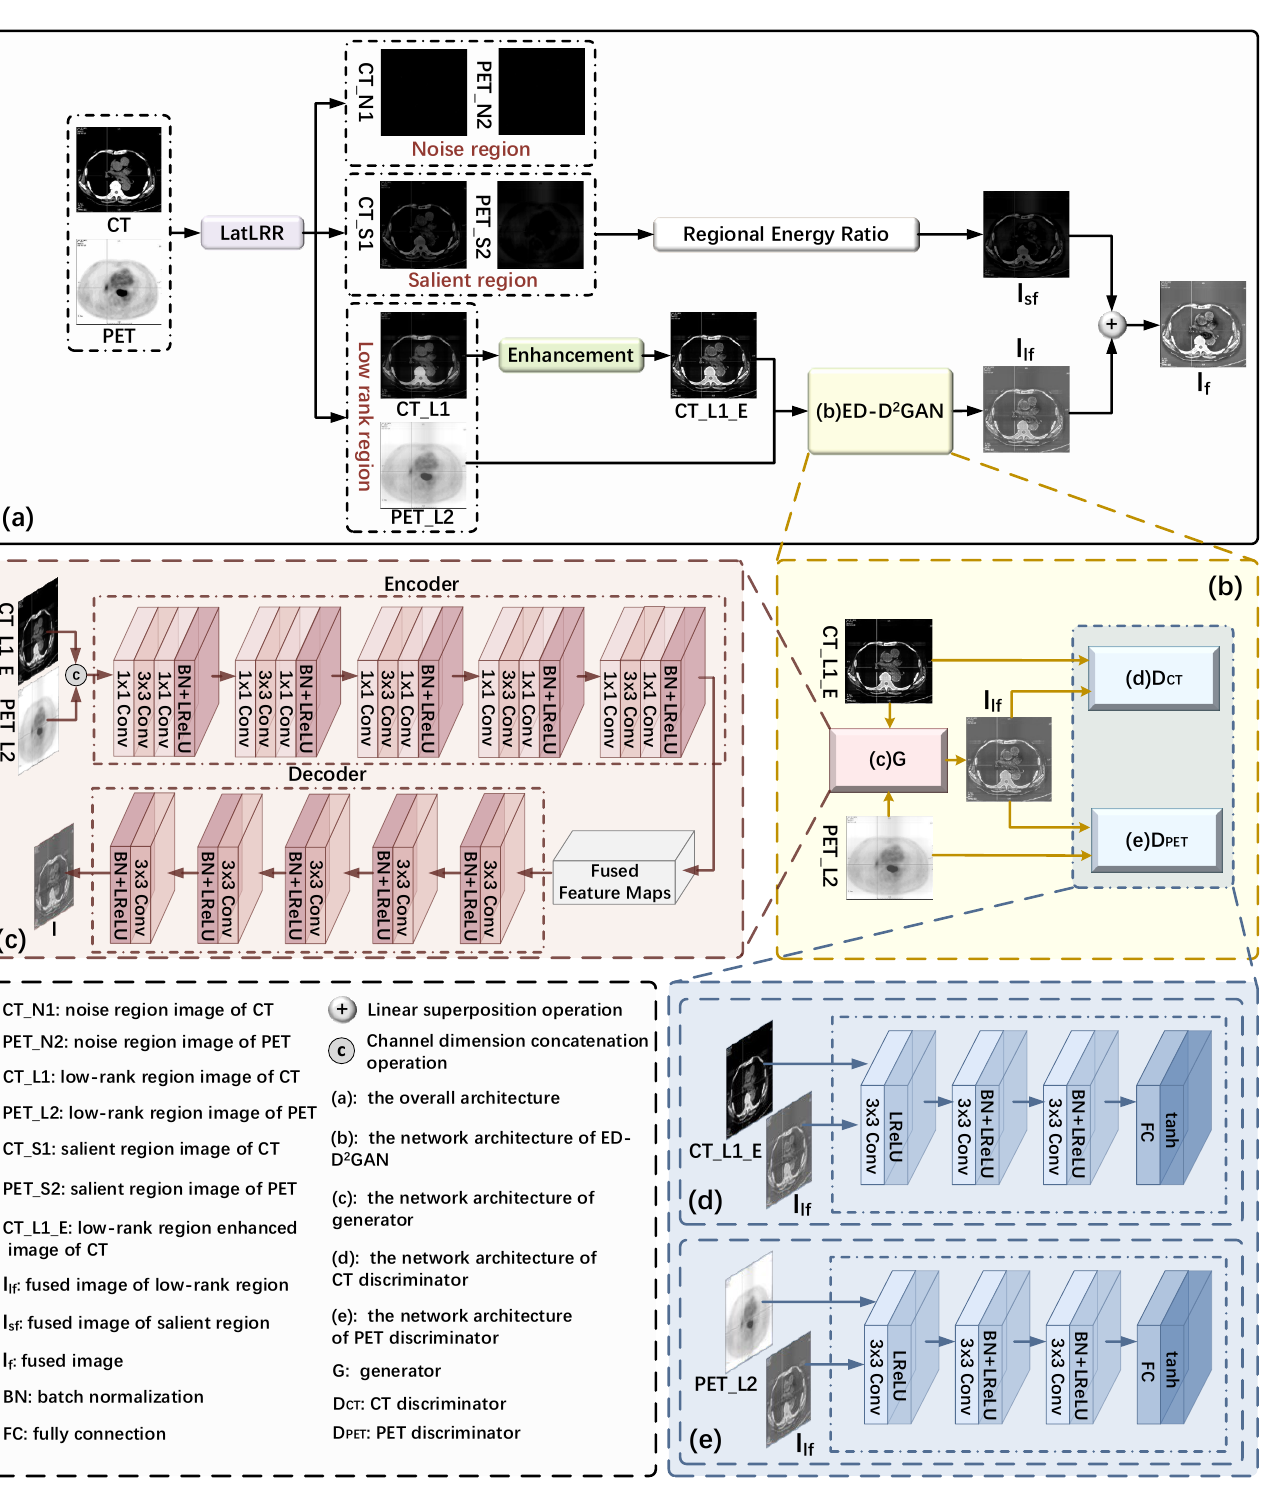
Figure 1. The overall network architecture. ( a ) The overall framework process; ( b ) the overall network architecture of ED-D 2 GAN; ( c ) the network structure of the generator; ( d ) the network structure of the CT discriminator of ED-D 2 GAN; and ( e ) the network structure of the PET discriminator of ED-D 2 GAN.